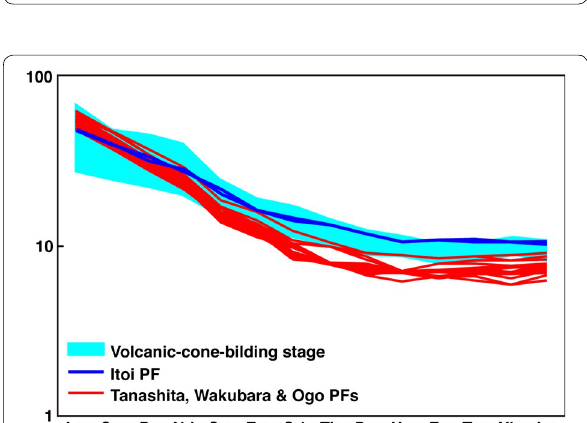
Fig. 8 Cumulative magma volume erupted from Akagi Volcano. A red solid line represents an eruption event. A lilac line shows a tendency of the eruption rate. A pink square shows the ranges of vol- ume and age for a volcanic edifice which is undivided into separate eruption events. P1, P2 and P3 are sub-stages in the pumice-eruption stage (Yamamoto 2016)